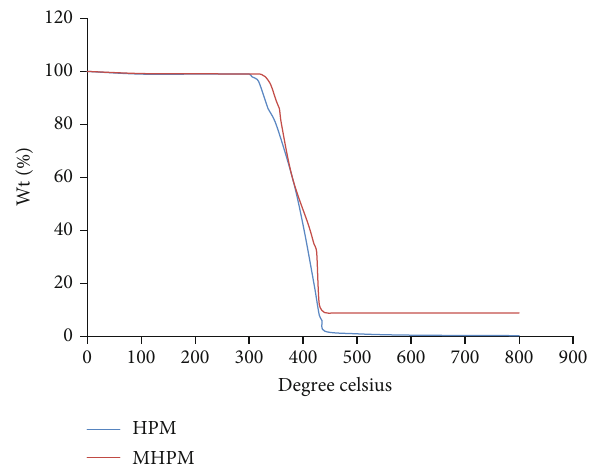
Figure 5: TGA analysis of HPM (blue) and MHPM